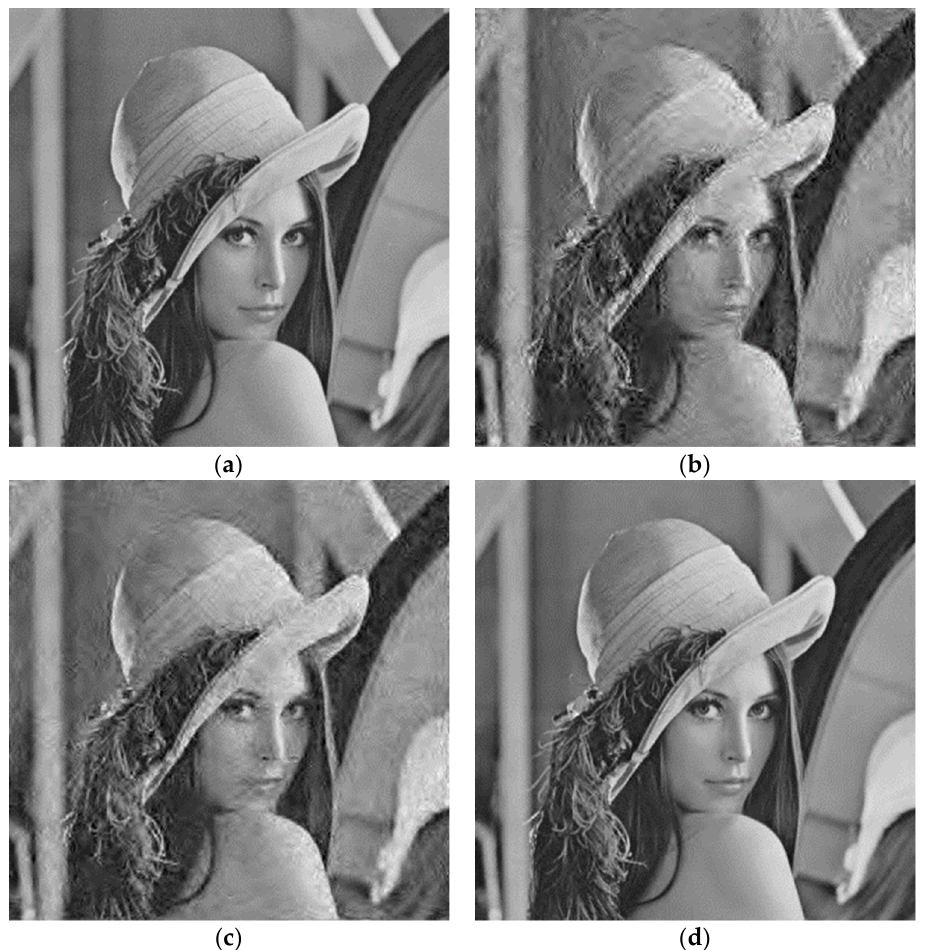
Figure 21. Reconstruction of images under different schemes. ( a ) is the original image, and image ( b–d ) are reconstructed images using the three schemes, respectively.